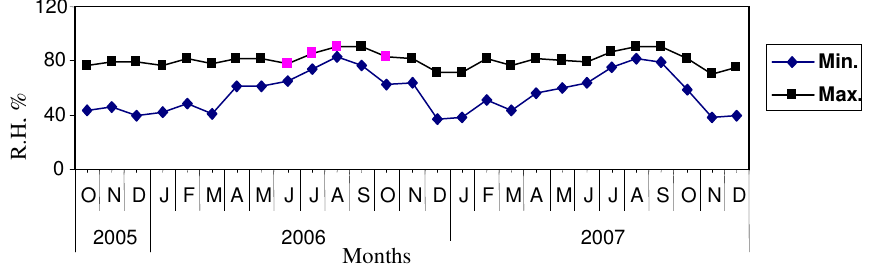
Figure 1. Average relative humidity (R.H.) in percentage at an urban